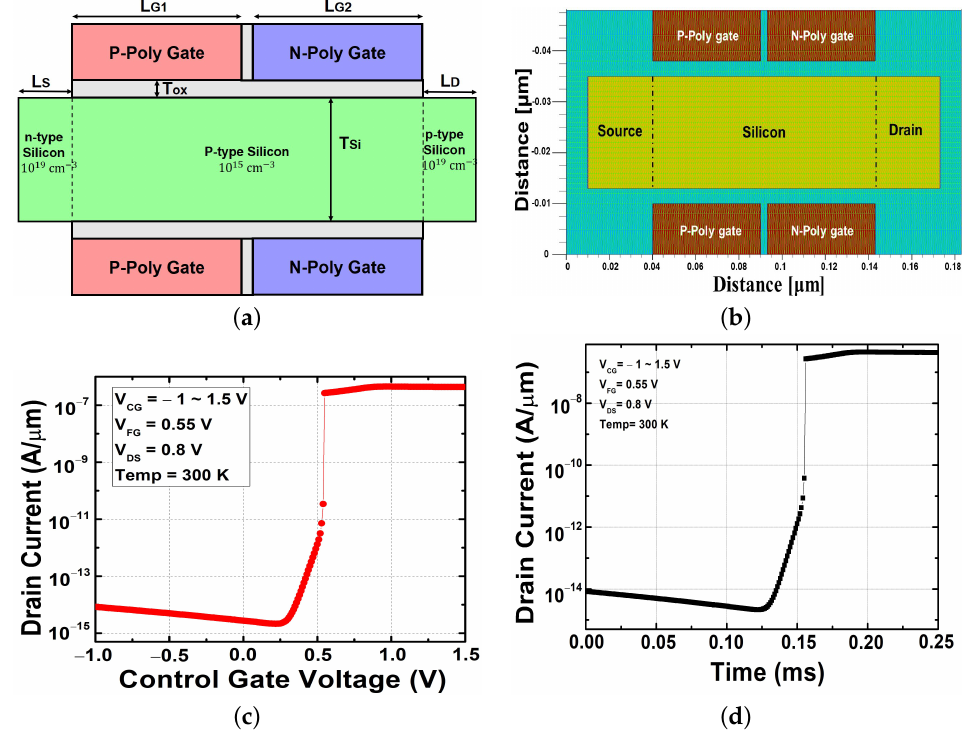
Figure 1. Proposed architecture: ( a ) scheme structure of dual-gate feedback field-effect transistor, ( b ) mesh set up for device simulation, ( c ) transfer characteristic, and ( d ) transient characteristic at the previous bias condition